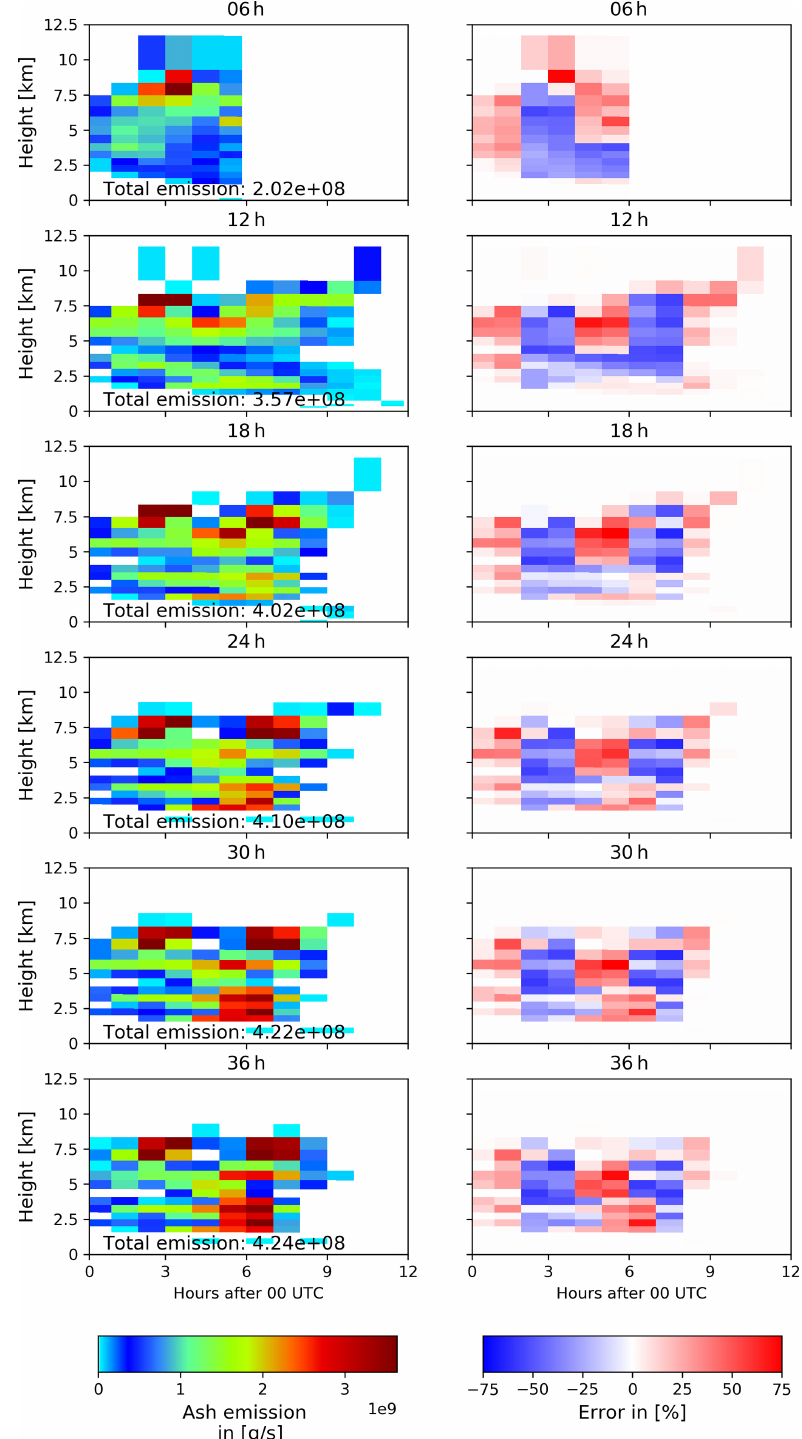
Figure A2. Emission profile of the ensemble mean (left panels) and its relative error to the nature run emission profile (right panels) for different assimilation window lengths on 29 April